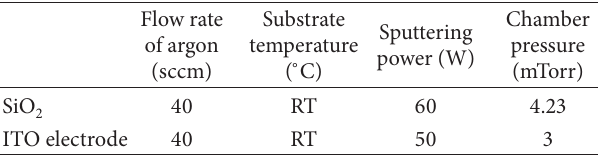
Table 1: Parameters of deposition of insulator and ITO electrode layers by